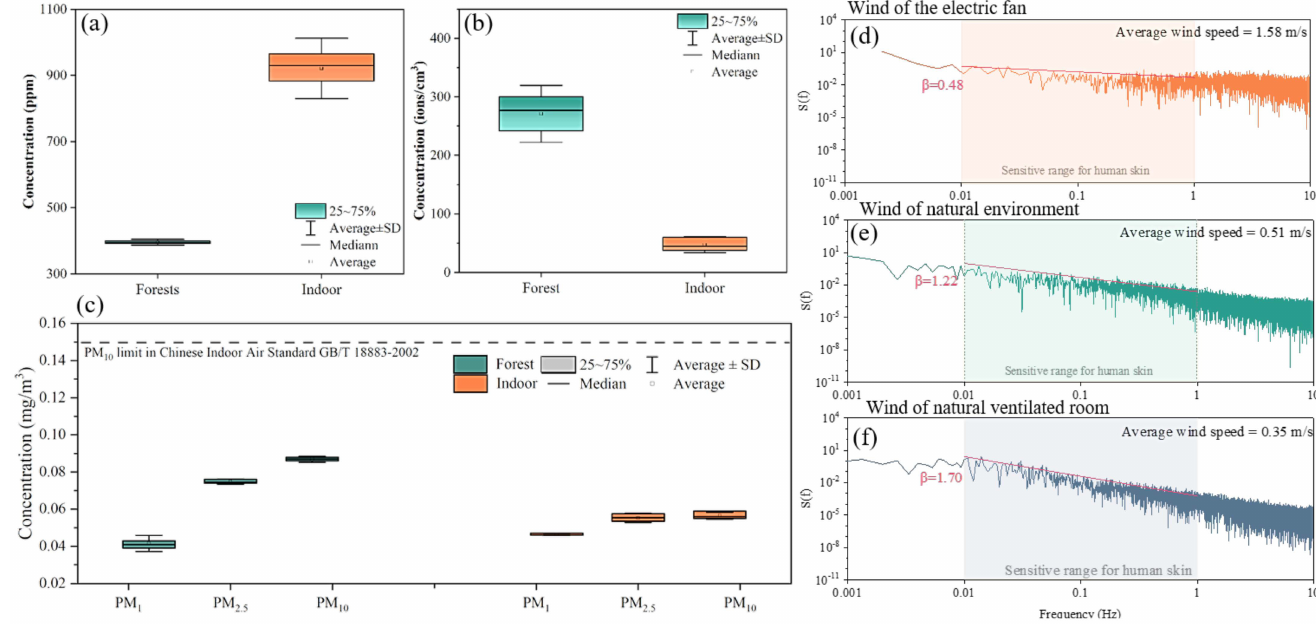
Figure 5. Air parameters for the forest park and the classroom: ( a ) concentration of CO 2 ; ( b ) concen- tration of NAI; ( c ) concentration of PM 1 , PM 2.5 , and PM 10 ; and ( d ) power spectrum of the wind of electric fan; ( e ) power spectrum of the wind of natural environment; ( f ) power spectrum of the wind of natural ventilated